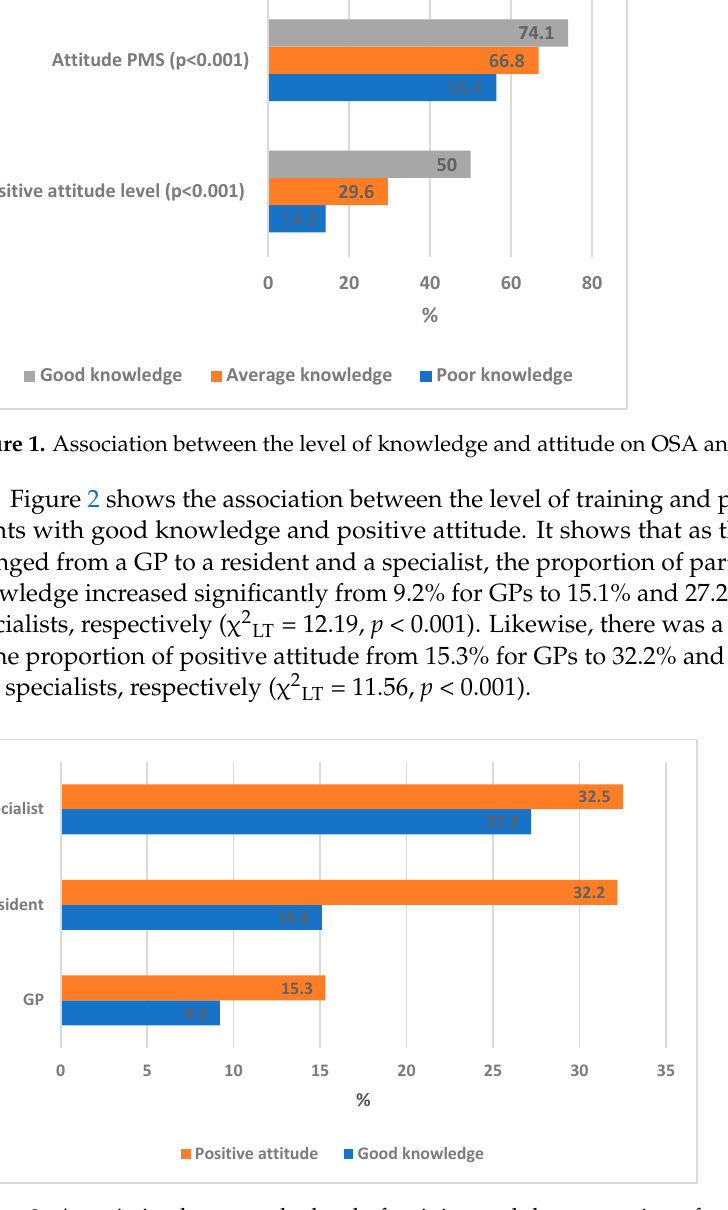
Figure 2. Association between the level of training and the proportion of participants with good knowledge and positive attitude.